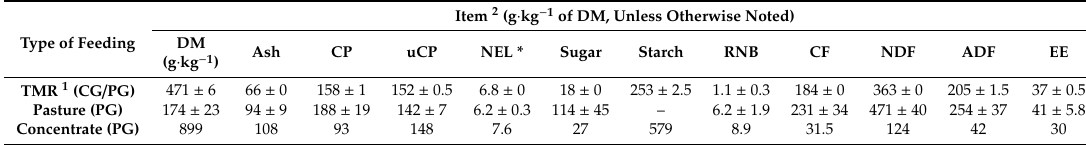
Table 1. Chemical composition of experimental diets (mean ±